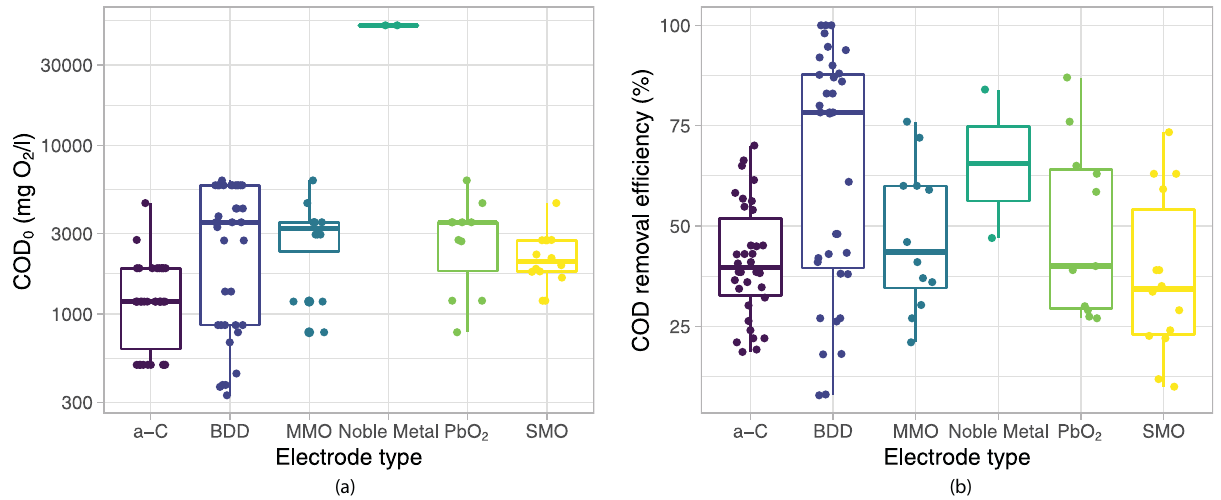
Fig. 1. Boxplots of (a) the initial COD concentration and (b) the COD removal ef fi ciency for every considered test, grouped by electrode type.